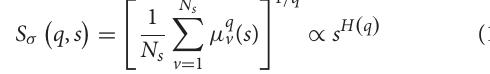
FIGURE 1 | Various representations of the measured NIRS signals. (A) Resting-state raw NIRS signal components. (B) Variance profiles of different signal components. (C) Variance profiles of HbT calculated at different set cross-correlation levels. (D) Fractal correlation coefficient between HbO and HbR as a function of scale. In this paper multifractal scaling function values are actually given by S σ ( q , s ) [or by S σ ( s ) for q = 2], where the subscript σ refers to the measure of the chosen multifractal method